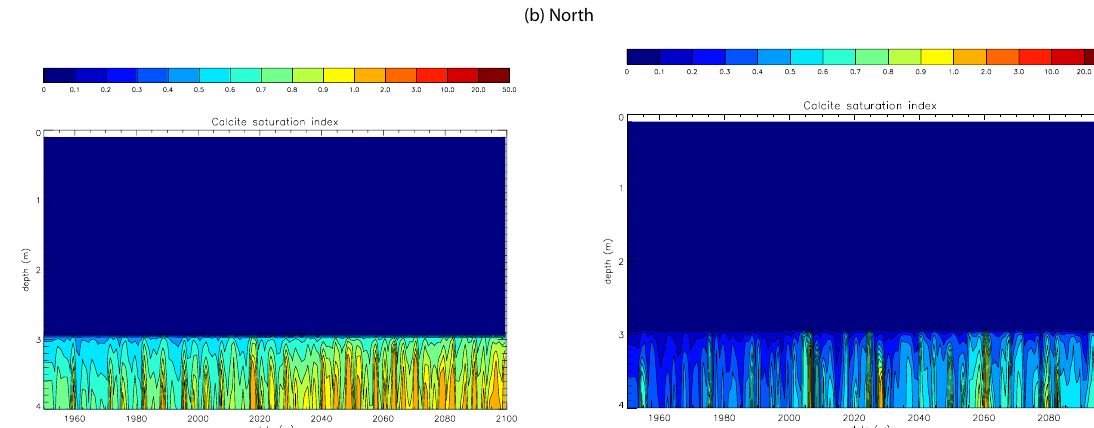
Fig. 9. Calculated saturation state of the soil solutions with respect to calcite plotted as a function of depth and time: (a) south pedon, (b) north